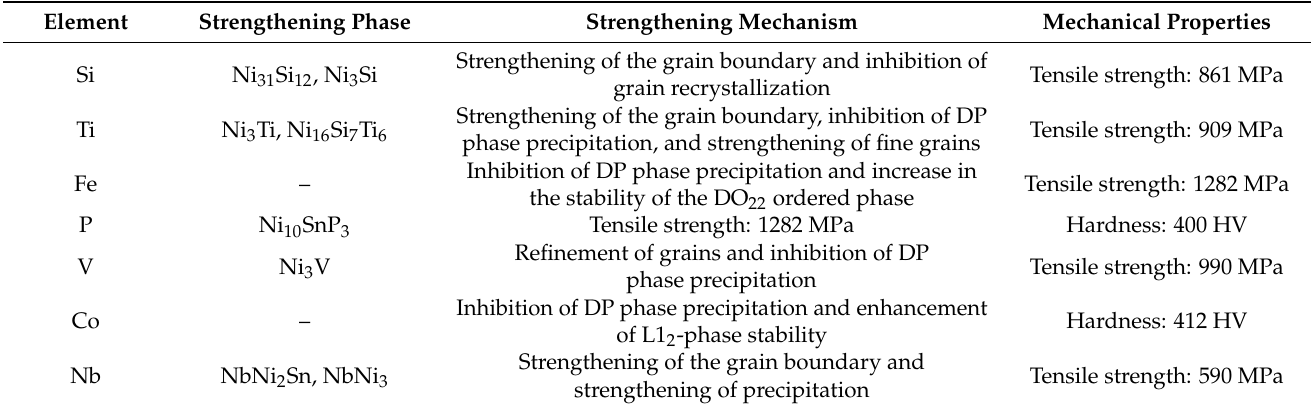
Table 2. Effect of alloy elements on microstructure and